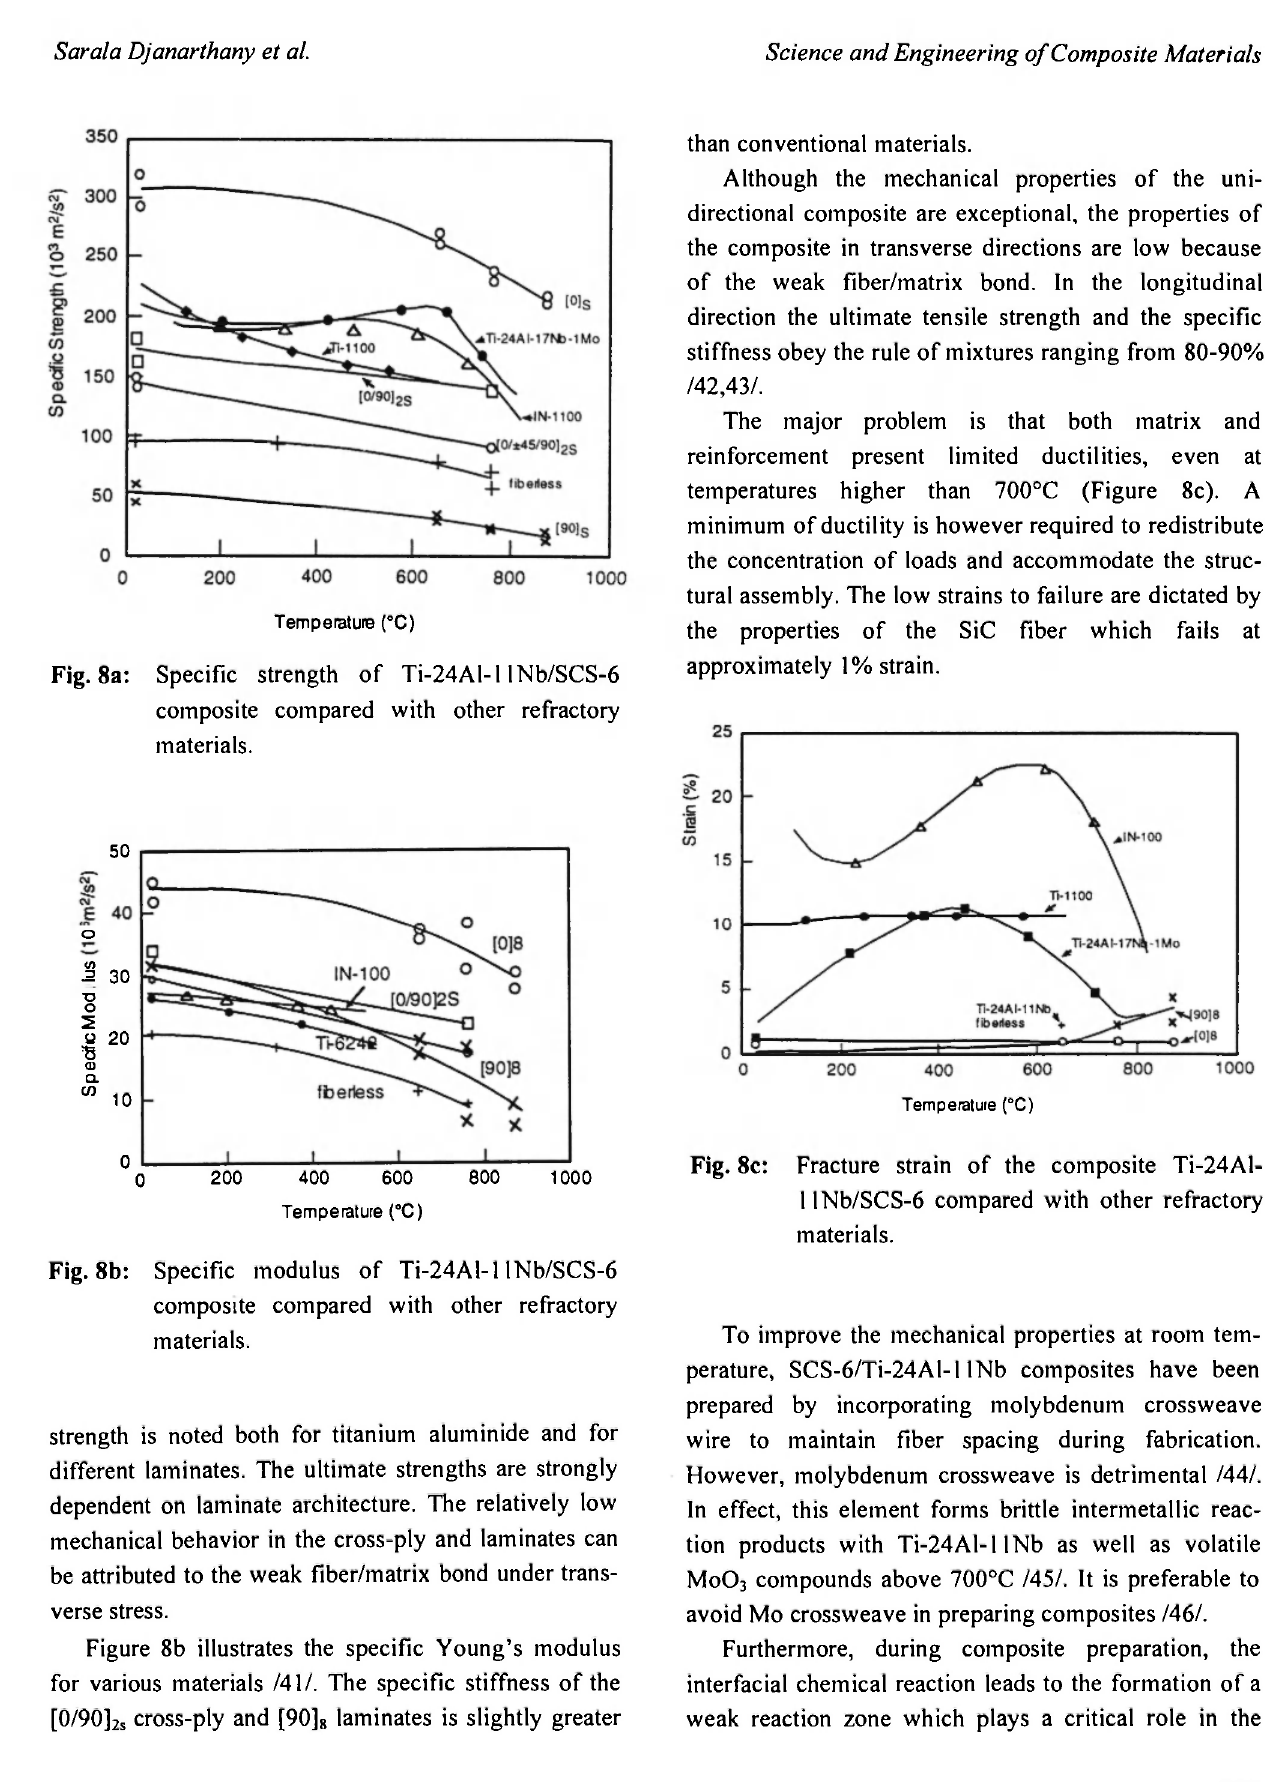
Fig. 8c: Fracture strain of the composite Ti-24A1- llNb/SCS-6 compared with other refractory